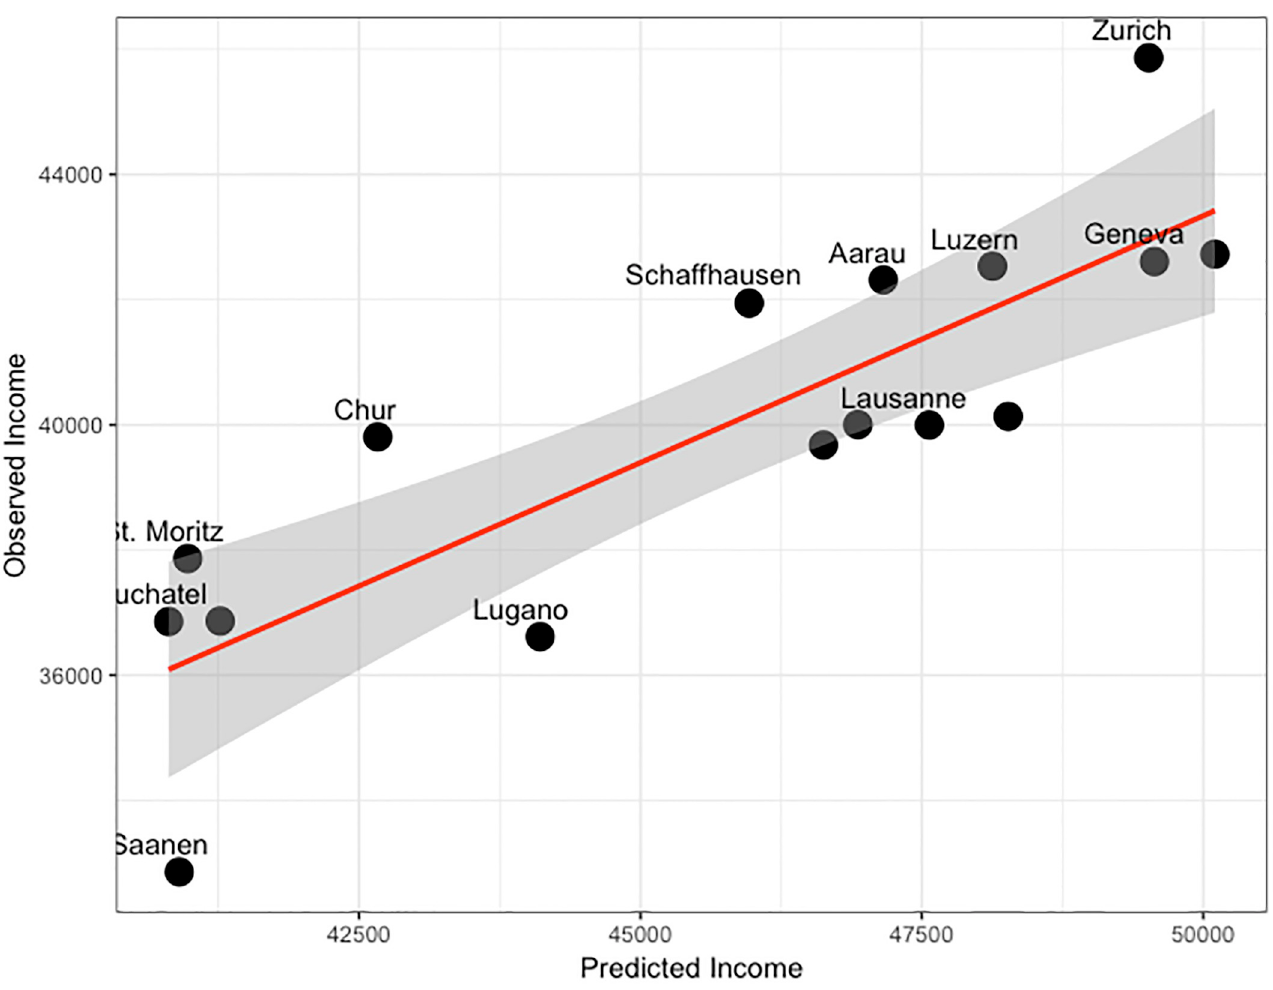
Fig 5. Comparison of modelled median income and observed median